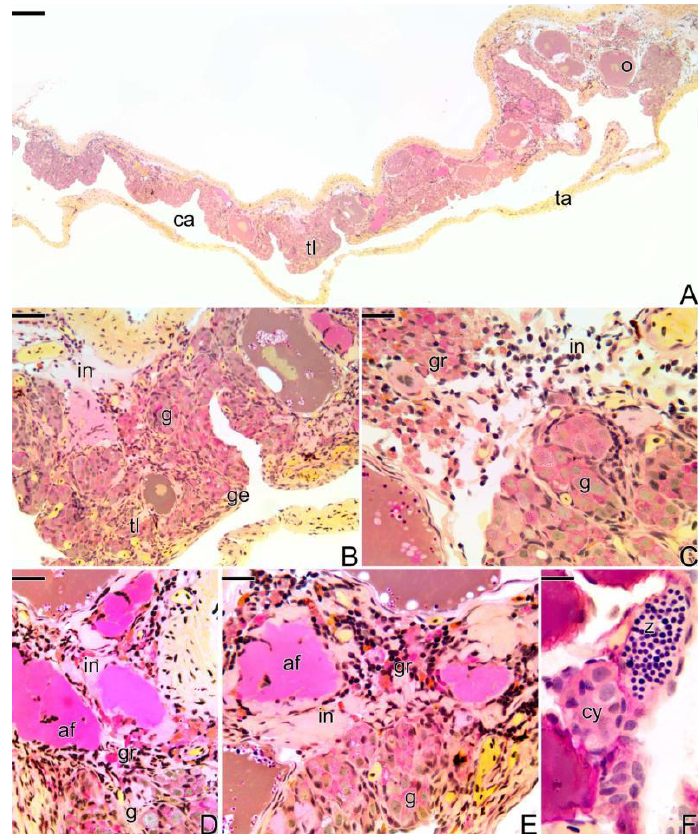
Figure 5. Histological section of final transitional gonad—the intersex of S. marmoratus . ( A ) General view of the gonad. ( B – F ) Details of A. Note the organization of the gonad in testicular lamellae ( B ) and the large amount of granulocytes that invade the interstitial tissue ( C – E ) close to atretic follicles ( D , E ). ( F ) Presence of the first spermatozoa. Coelomic cavity (ca), testicular lamellae (tl), tunica albuginea (ta), oocyte (o), interstitium (in), germinal epithelium (ge), gonia (g), granulocytes (gr), atretic follicle (af), spermatozoa (z). Staining: MY. Bar: 100µm ( A ), 50µm ( B ), 20µm ( C – E ), 10µm ( F ).